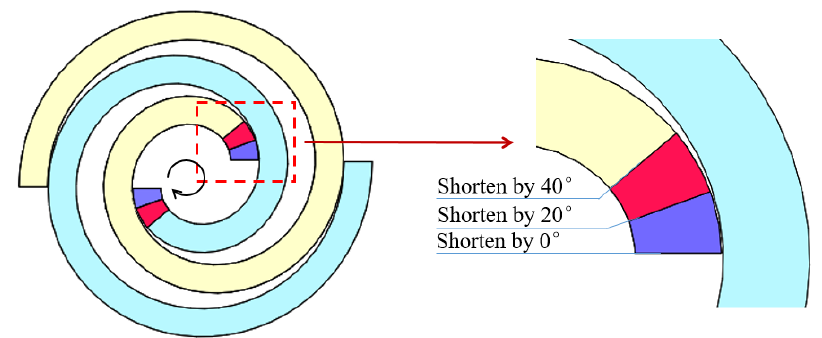
Figure 18. Schematic diagram of scroll profile shortening position.